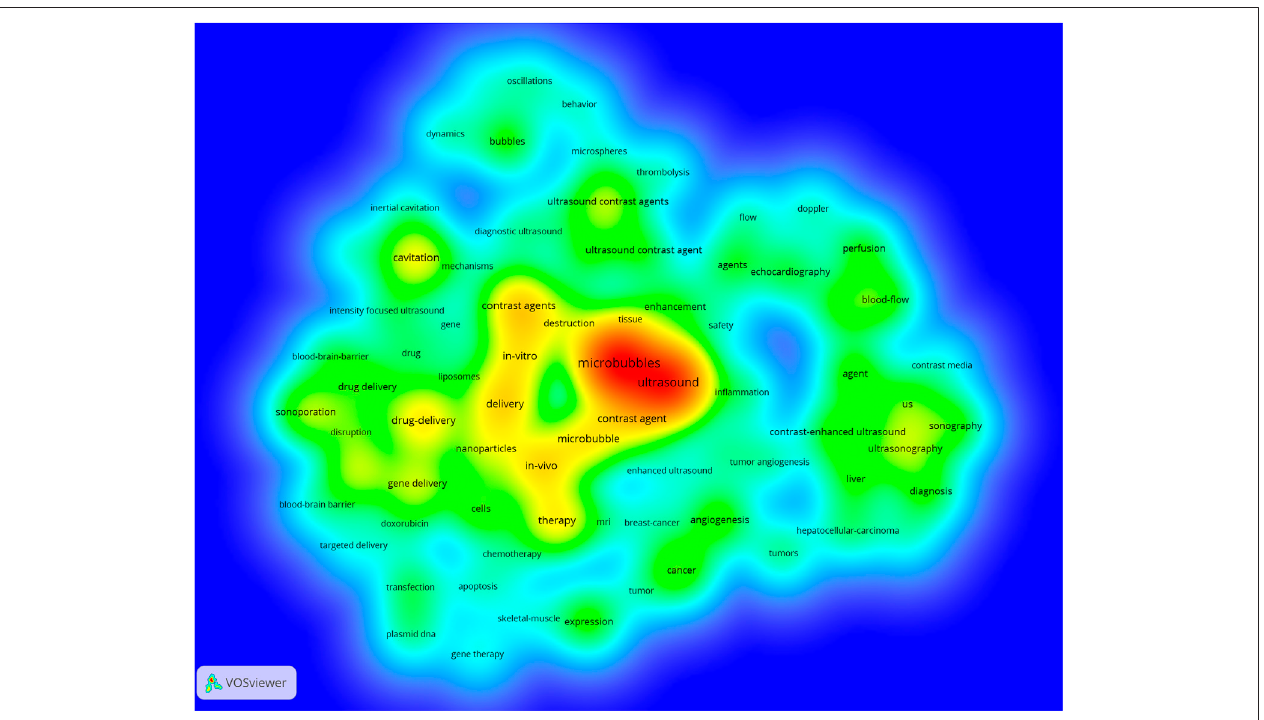
FIGURE 9 | Density map of keywords generated by the VOS viewer. The deeper the color of a node, the more frequently keywords appear.